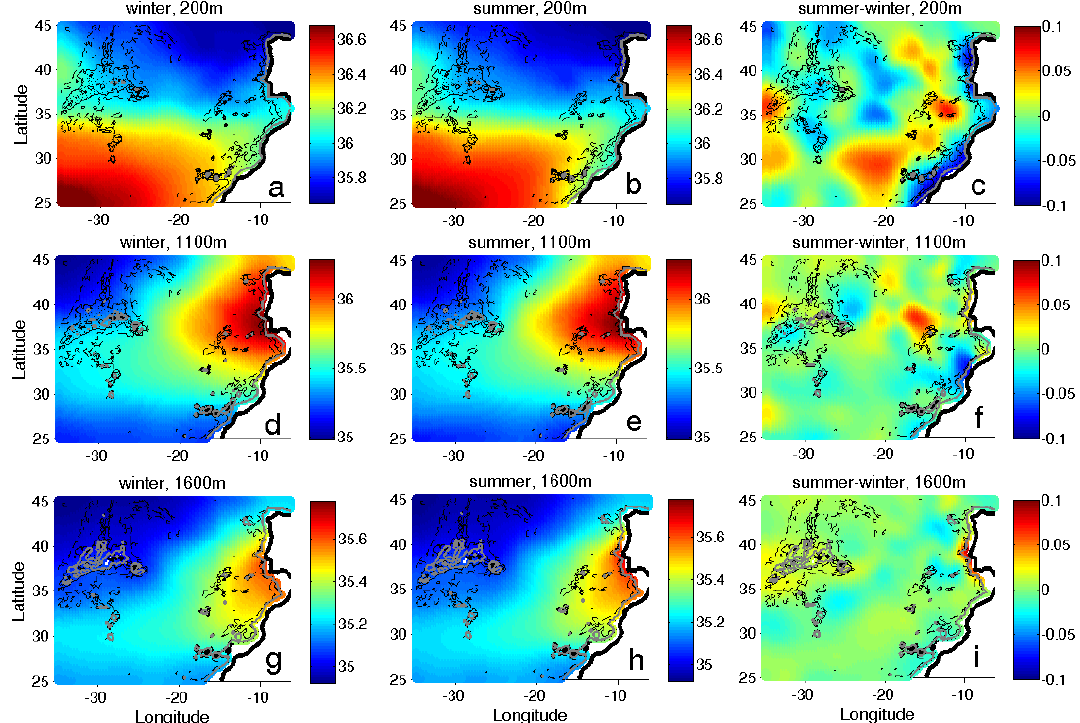
Figure 12. Salinity at (a, b) 200m, (d, e) 1100m and (g, h) 1600m: (a) , (d) and (g) – winter; (b) , (e) and (h) – summer; (c) , (f) and (i) – difference between the summer and winter